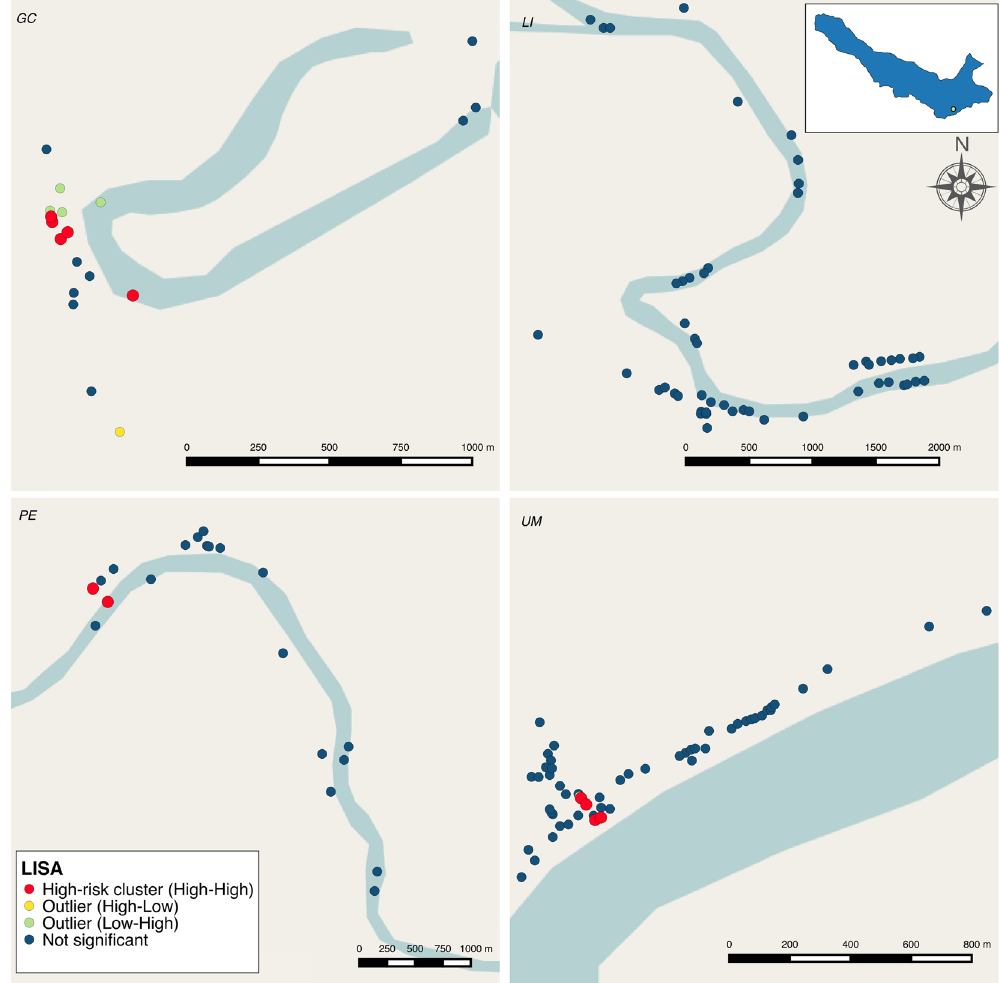
Figure 4. Local Indicators of Spatial Association (LISA) clustering analysis of P . vivax parasitaemia in: Gamitanacocha ( GC ), Libertad ( LI ), Primero de Enero ( PE ) and Urco Miraño ( UM ). Each point represents a household location. Statistically significant clusters corrected by false discovery rate were represented as follows: Households with high parasitaemia surrounded by a neighborhood with high parasitaemia (High-risk cluster − red circles), households with high parasitaemia surrounded by a neighborhood with low parasitaemia (High- low outlier − yellow circles) and households with low parasitaemia surrounded by a neighborhood with high parasitaemia (Low-high outlier − green circles). Map generated with QGIS 2.16 (QGIS Development Team,